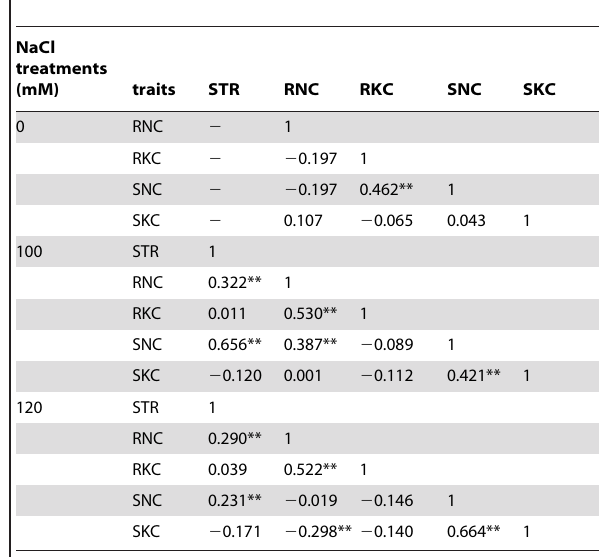
RNC: root Na + concentration; RKC: root K + concentration; SNC: shoot Na + concentration; SKC: shoot K + concentration; STR: salt tolerance rating; **indicates significance at the level of 1%.